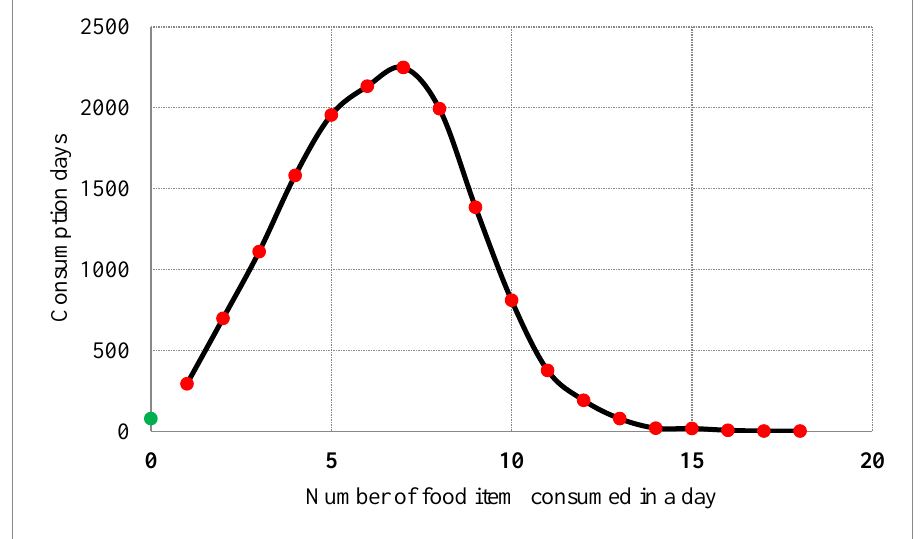
Figure 1. Number of food item(s) consumed in one day by one consumer [44].